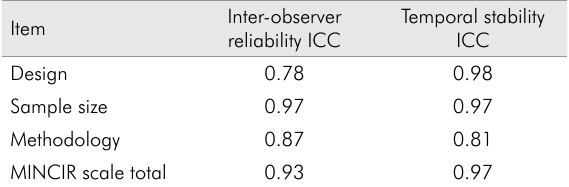
Table 2. Inter-observer reliability and temporal